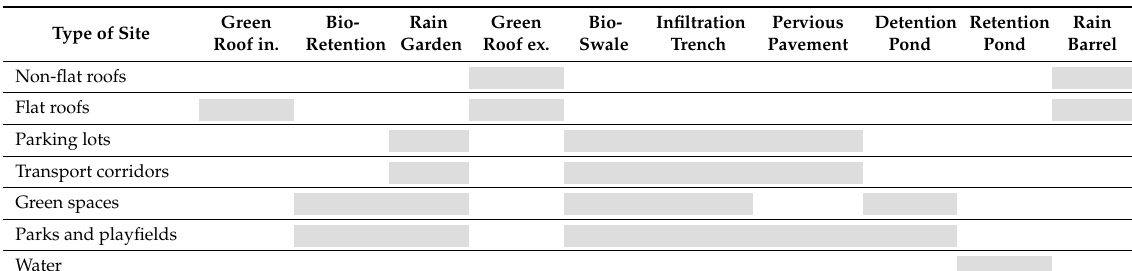
Figure 4. Location of different land uses in the study area. Table 3. Suitability analysis of GI placement sites.